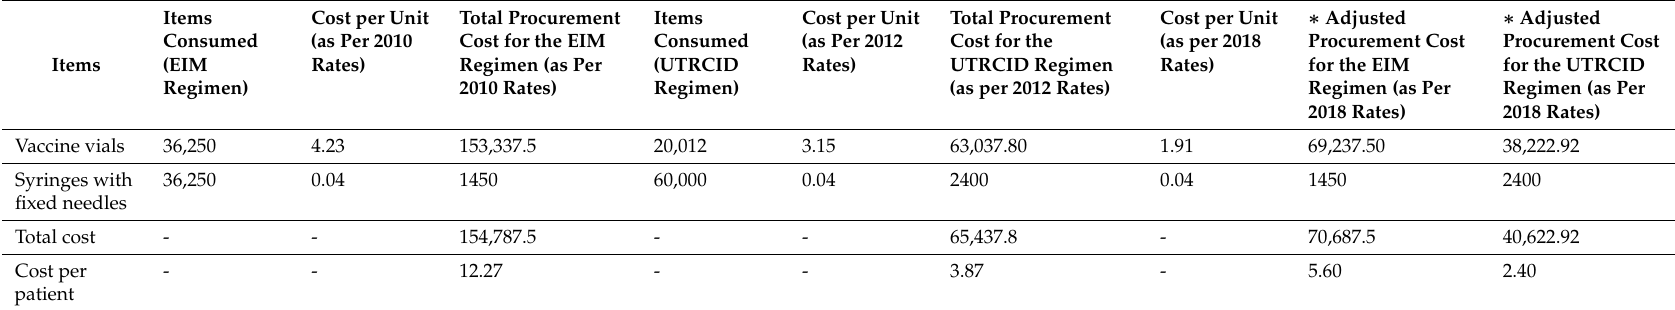
Table 1. Consumption pattern and procurement costs of various items required for rabies vaccination via the Essen intramuscular (EIM) regimen and updated Thai Red Cross intradermal (UTRCID)